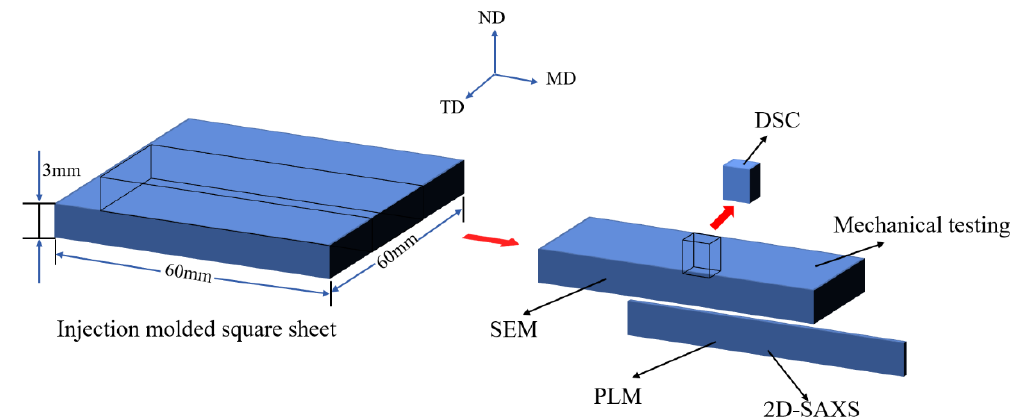
Figure 1. The schematic drawing of sampling methods for each analyzes (MD: Flow direction, TD: TD: Transverse direction, and ND: Normal Transverse direction, and ND: Normal direction.).